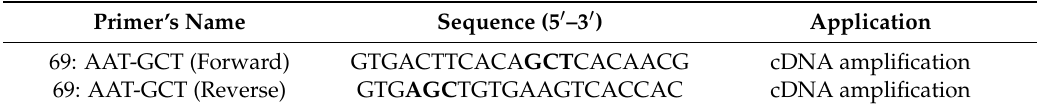
Table 2. Primers used for mutation in yellow catfish CypA. In both primers, the Asn amino acid is replaced by the Alan amino acid at position 69, which produced the CypA mt protein. The codons for Alan (GCT and AGC) are presented bold in both forward and reverse